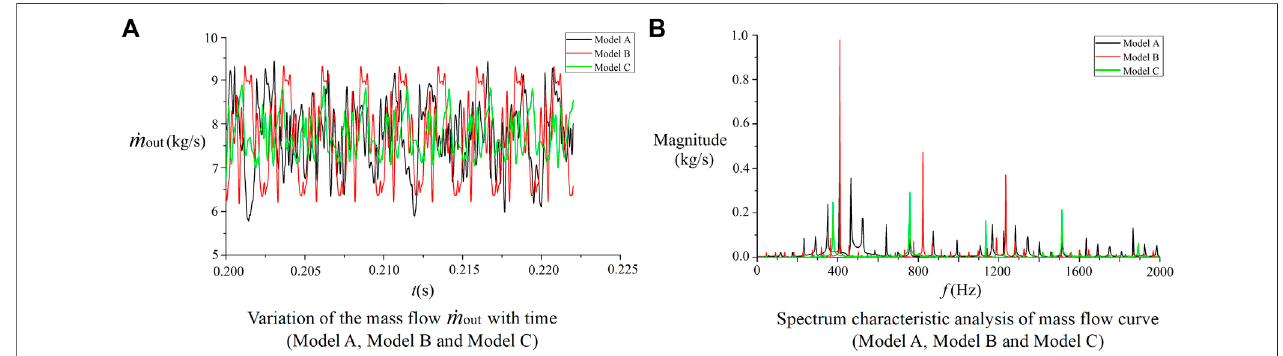
FIGURE 9 | Variation of the mass fl ow of